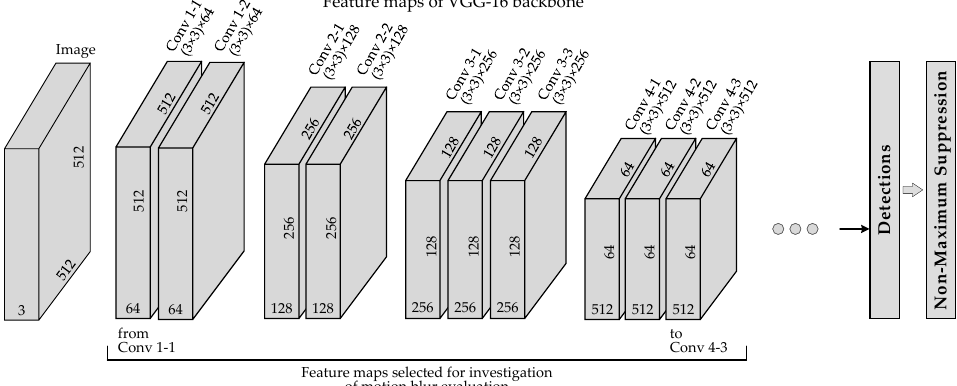
Figure 2. Partial structure of the convolutional neural network (CNN) model used for human head detection. Features from the first 10 feature maps (outputs of convolutional layers) of the VGG-16 backbone were investigated for suitability to predict motion blur level in the presented image. Names and filter shapes of the convolutional layers are given above the boxes that denote feature maps. The numbers in the boxes specify the shape of the feature